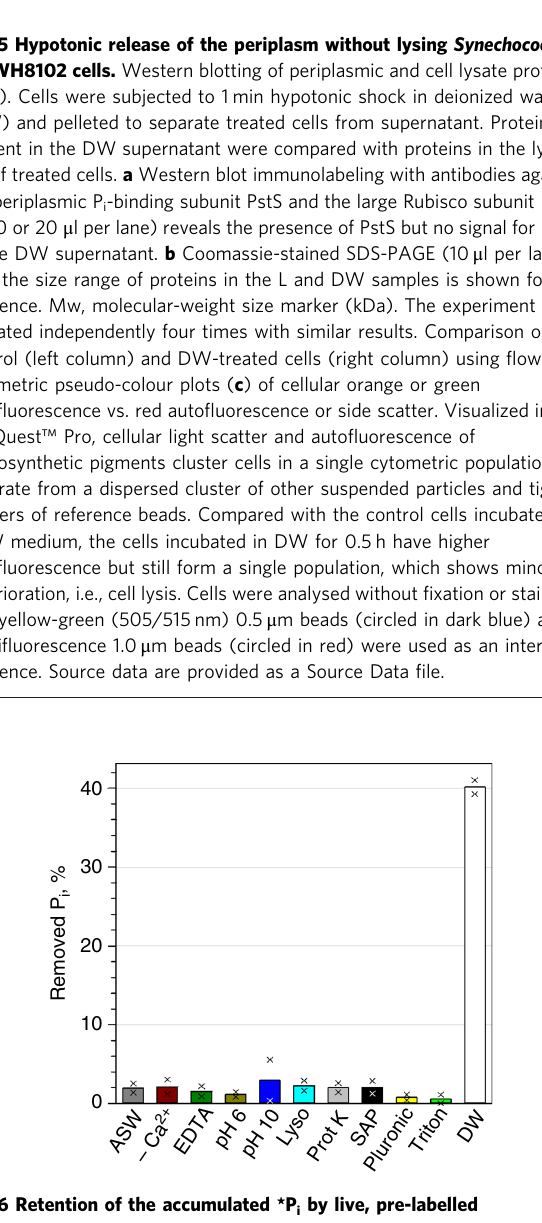
Fig. 6 Retention of the accumulated *P i by live, pre-labelled Synechococcus sp. WH8102 cells. Minor removal of P i label was achieved by the following treatments: ASW, cells washed with arti fi cial seawater; -Ca 2 + , cells washed with ASW without Ca 2 + ; EDTA, cells washed with isotonic NaCl solution containing EDTA; pH 6 and pH 10, cells washed with ASW at pH 6 and at pH 10, respectively; Lyso and Prot K, cells incubated with lysozyme and Proteinase K, respectively for 15 min; SAP, cells incubated with shrimp alkaline phosphatase for 30 min; Pluronic and Triton, cells incubated with the surfactants Pluronic F-68 and Triton X-100, respectively, for 15 min. A short wash with deionized water (DW) removed about 40% of the P i label. The plot summarizes the results of the representative experiments. Bars present mean values of technical duplicates indicated as crosses. Horizontal grey lines indicate major ticks of the Y-axis to assist comparisons. For details, refer to Supplementary Tables 5 and 6. Source data are provided as a Source Data fi le.